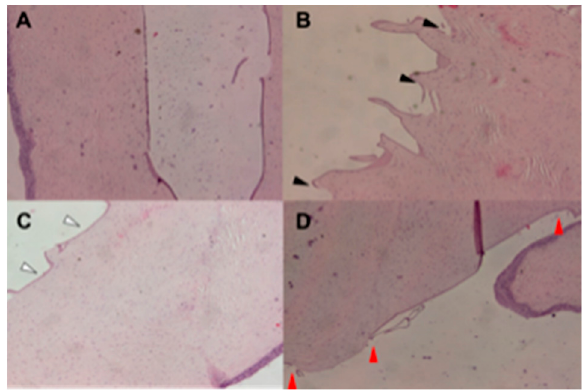
Figure 1. ( A ) Hematoxylin and Eosin (H&E) staining of the corneal tissue obtained from the rabbit eyes of Control Group (CG). Normal corneal thickness and normal morphology of the corneal layers in the control sample. Original magnification × 20. ( B ) H & E staining of the corneal tissue obtained from the rabbit eyes of Irradiated Group (IG). Serious increase in thickness, detachment of residual fragments of Descemet membrane, which appears disappearance for destruction and micropapillary changes (see black arrows). Original magnification × 20. ( C ) H & E staining of the corneal tissue obtained from the rabbit eyes of Irradiated Group (IG30). Moderate increase in thickness, mild edema of the endothelial layer and slight increase in thickness of Descemet membrane (see white arrows). Original magnification × 20. ( D ) H & E staining of the corneal tissue obtained from the rabbit eyes of Irradiated Group (IG60). Severe increase in thickness, detachment of the Descemet membrane and edema of the endothelial layer (see red arrows). Original magnification × 20.